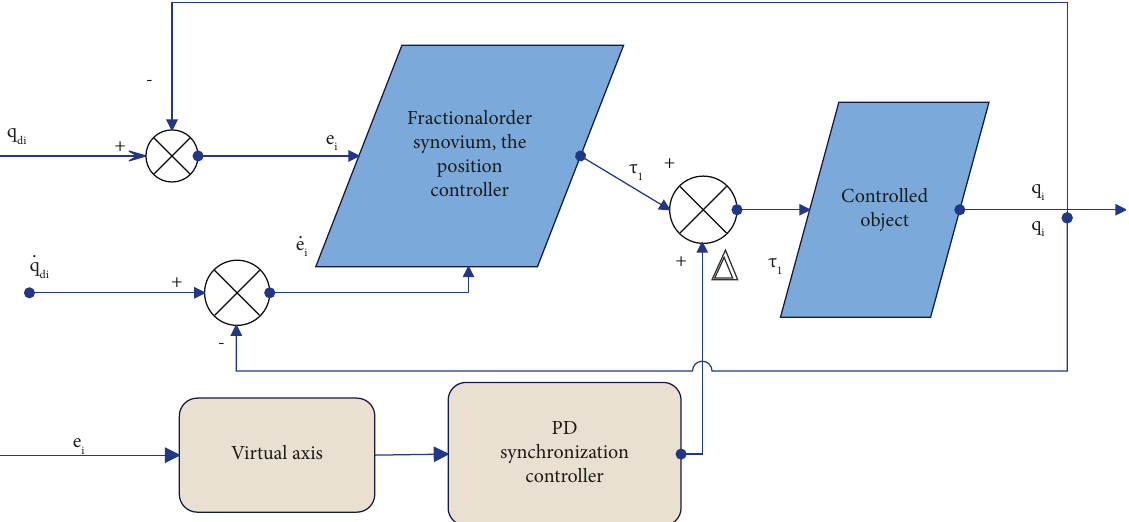
Figure 5: Block diagram of cross-coupling control of PD virtual spindle.